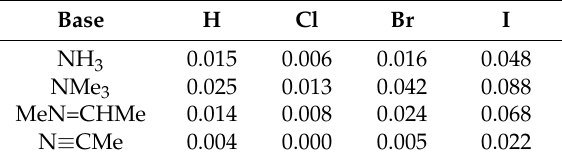
Table 8. Change in r(C-Z) bond length (Å) caused by complexation with ImZ + Lewis acid.